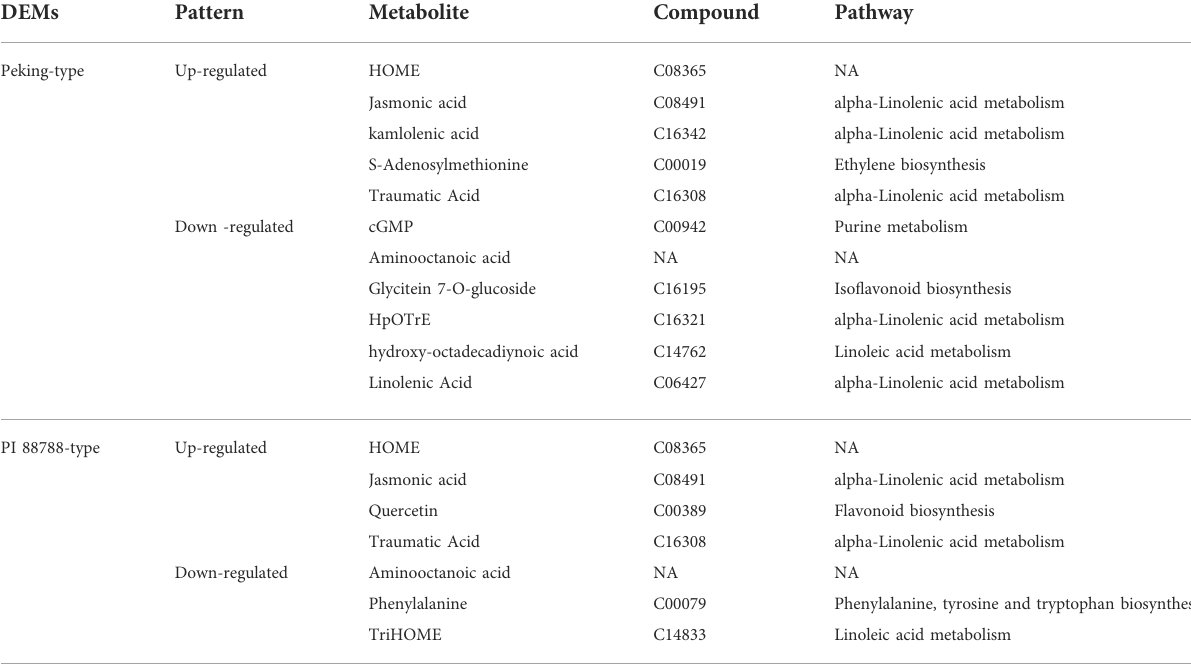
TABLE 4 Signi fi cant differentially expressed metabolites (DEMs) between Peking- and PI 88788-type sources of resistance. DEMs Pattern Metabolite